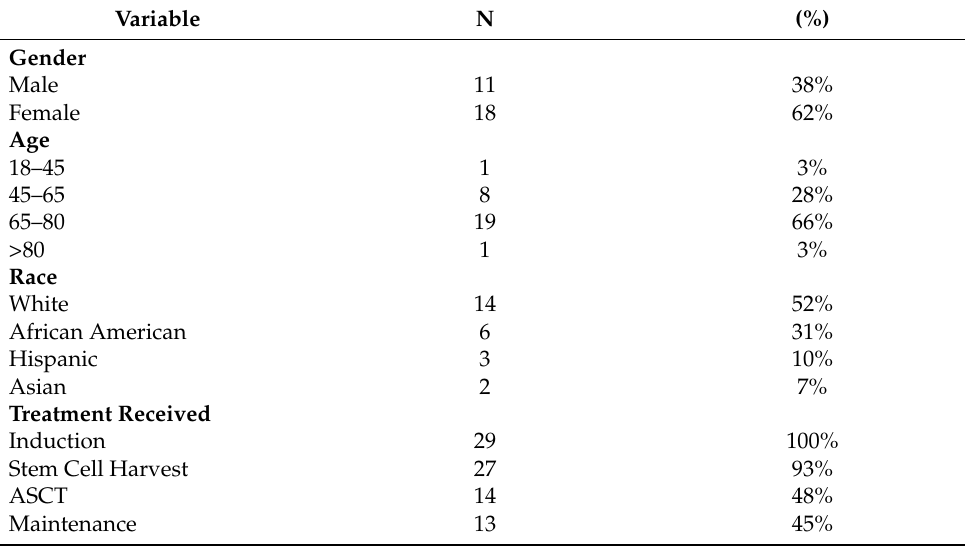
Table 1. Sociodemographic characteristics of patient